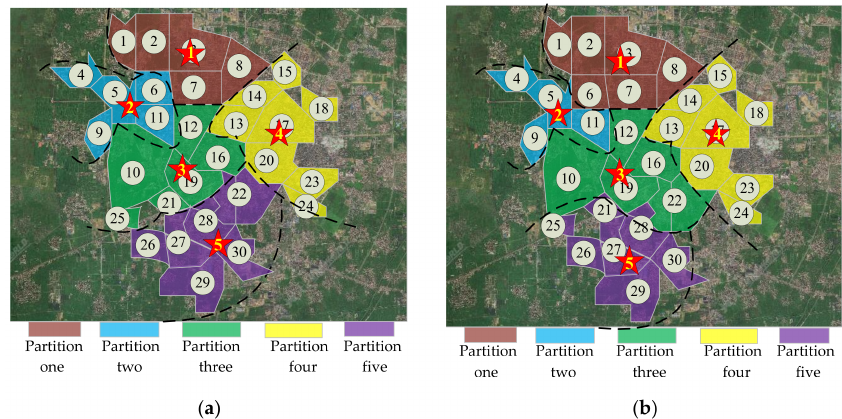
Figure 12. The partition situation of the typical new district under different planning methods. ( a ) Planning method in this paper; ( b ) Adaptive robust optimization method. Table 2. The coordinate positions of the integrated energy supply centres and the partition situation.